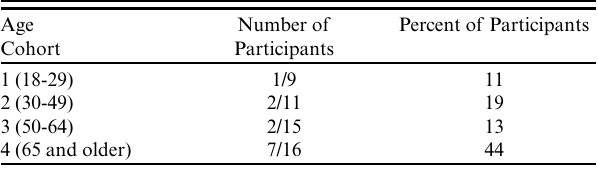
Table 5 . Observations of changing fall conditions by age cohort.